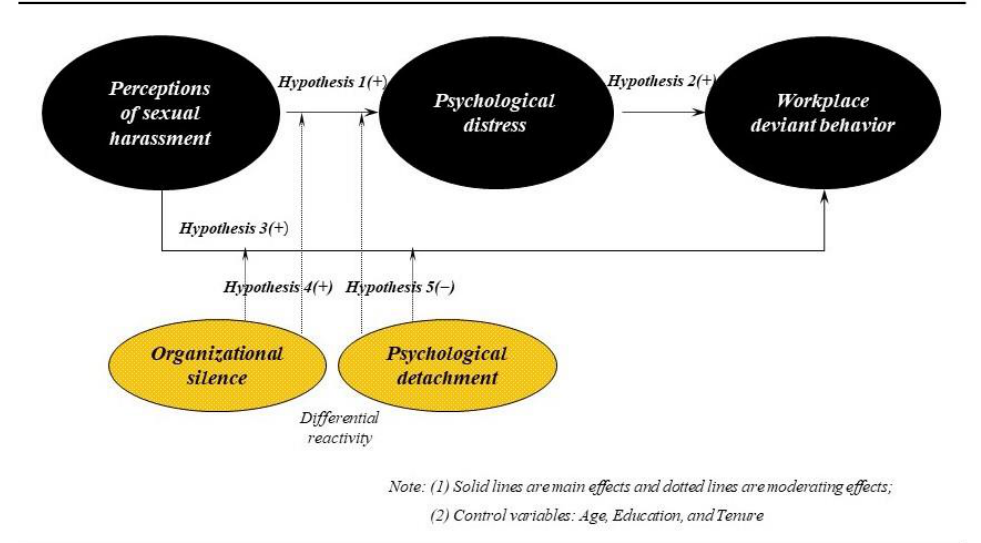
Figure 1. A proposed model of sexual harassment, psychological distress, workplace deviant behavior, organizational silence, and psychological detachment.